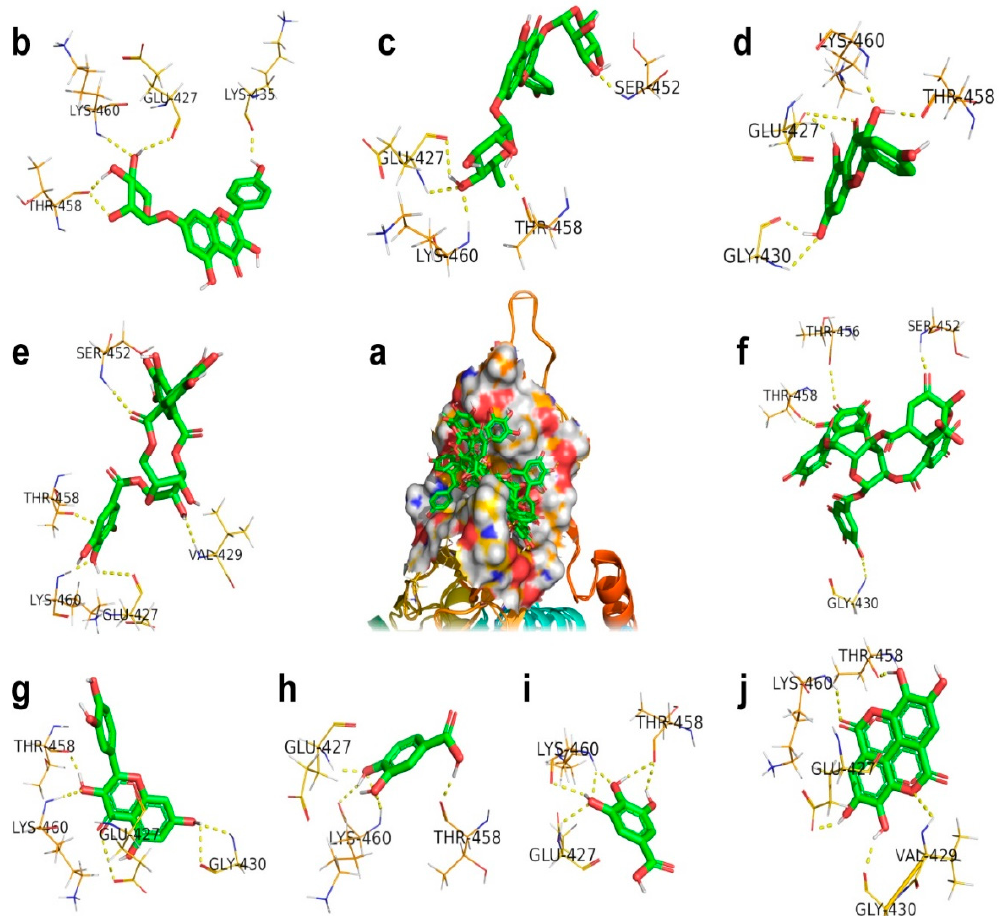
Figure 3. The docking mode of polyphenols present in Geranii Herba ( Geraniaceae ) with glucose- regulated protein 78 (GRP78). ( a ) The 9 polyphenols retained in the cavity of the surface region of GRP78. ( b ) Kaempferol_7_O. ( c ) Kaempferitrin. ( d ) Kaempferol. ( e ) Corilagin. ( f ) Geraniin. ( g ) Quercetin. ( h ) Protocatechuic. ( i ) Gallic acid. ( j ) Ellagic acid. Table 4. The binding details of polyphenols present in Geranii Herba ( Geraniaceae ) with glucose- regulated protein 78 (GRP78).